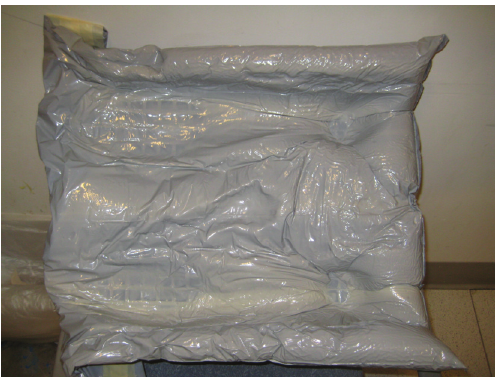
Figure 4: A premolded alpha cradle.